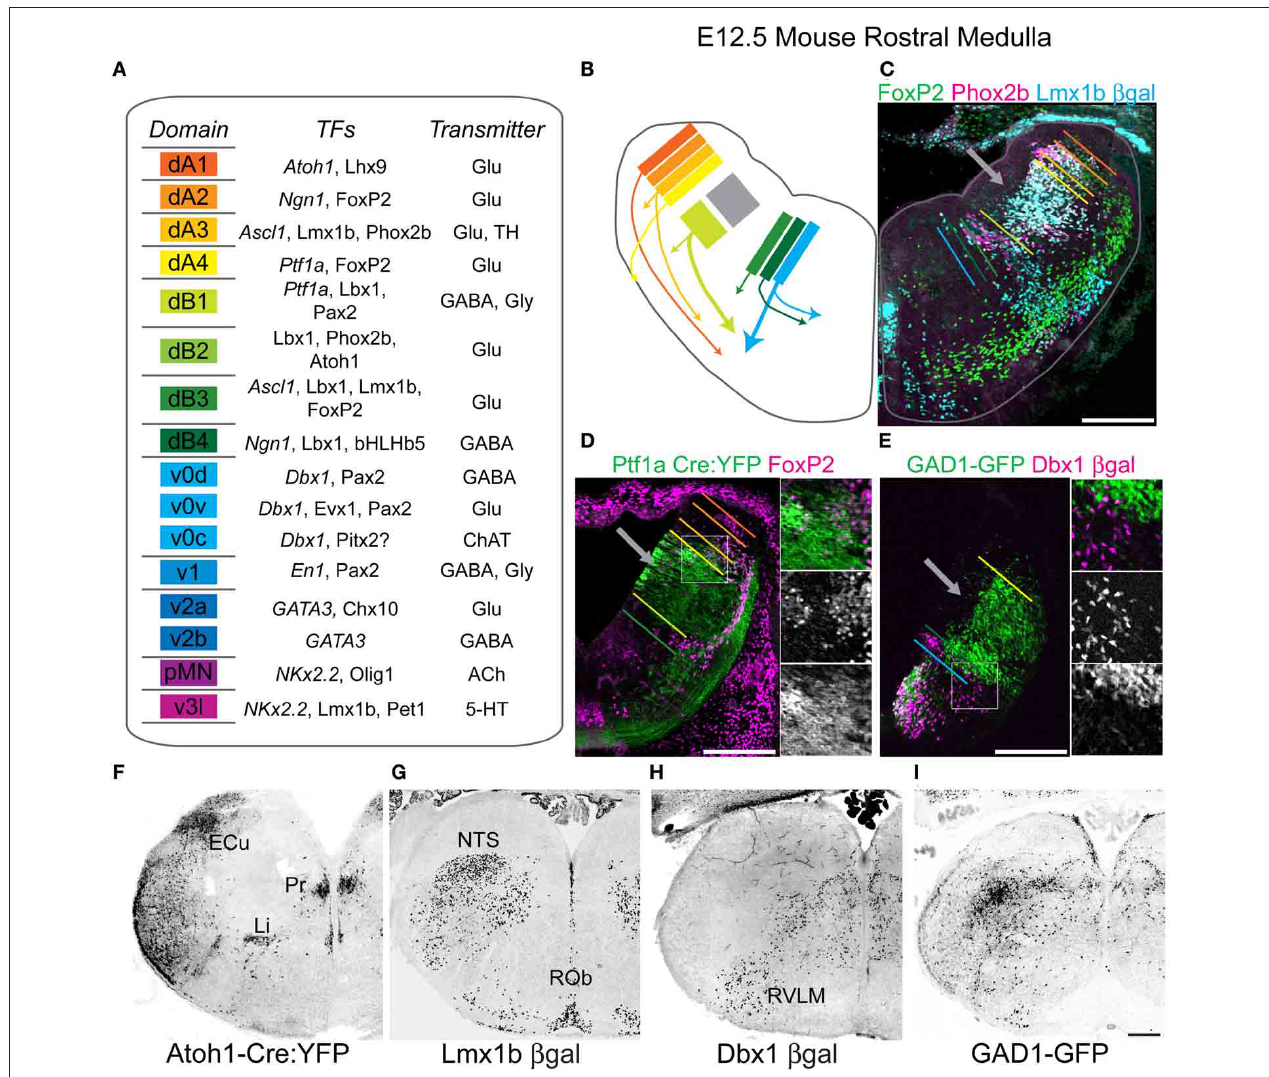
FIGURE 1 | Genetic diversity of hindbrain neurons. (A) Schematized diagram describing brainstem progenitor domains for eight dorsal (dA1–dB4) and 8 ventral progenitor populations (v0–v3l) based on their relative dorso-ventral location during neurogenesis (left). Partial list of transcription factors expressed within progenitors (italics) or post-mitotic neurons within each domain (middle). Neurotransmitter identity of neurons derived from each domain (right). (B) Cartoon showing partial migratory path of ventral medulla neurons in embryonic mouse brainstem. Colors correspond to domains in (A) . Thick arrows correspond to populations migrating to ventrolateral medulla. (C) Pseudo-color confocal image of FoxP2 (green), Pho × 2b (magenta), and β gal (cyan) expression in an E13.5 Lmx1b - β gal mouse showing the origin and migration of hindbrain neurons.